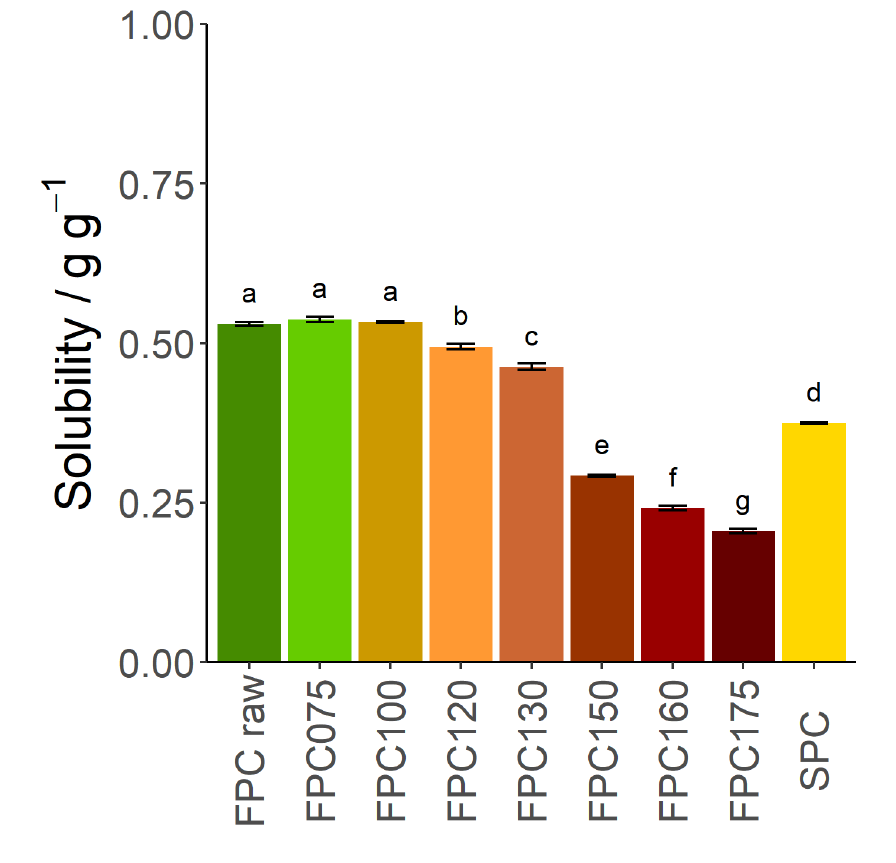
Figure 2. Solubility of the material of dry-heated and non-dry-heated FPC and commercial SPC. n = 3. Dry-heating at 75 ◦ C and 100 ◦ C had no influence on the solubility. Dry-heating at 120 ◦ C and 130 ◦ C slightly lowered solubility; while dry-heating at 150 ◦ C, 160 ◦ C, and 175 ◦ C cut solubility in half. SPC is shown as an industry